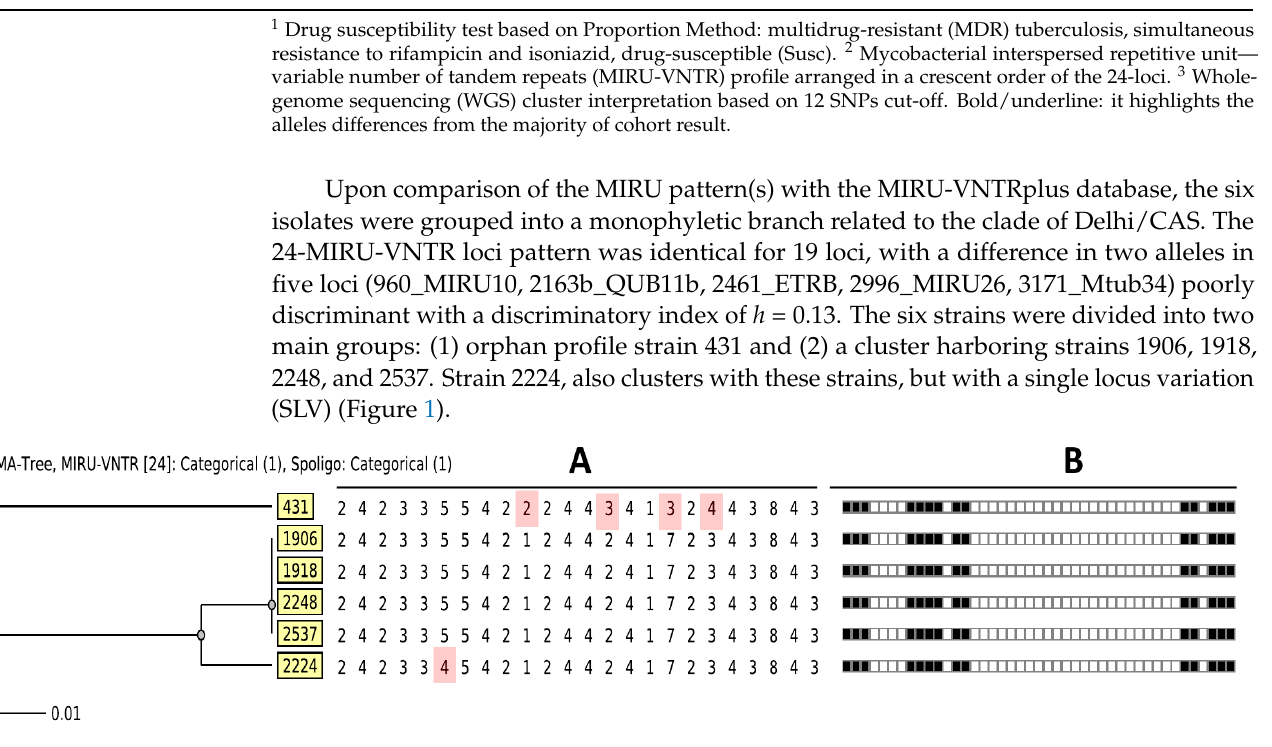
Figure 1. Phylogenetic tree ( A ) based on 24-MIRU-VNTR loci analysis on six Mycobacterium tuberculosis strains highlighting the quadruple-locus variation on strain 431 and a single-locus variation on strains 2224; identical spoligotyping profile ( B ) indicative of the Central-Asia (CAS) SIT 2545 genotype.